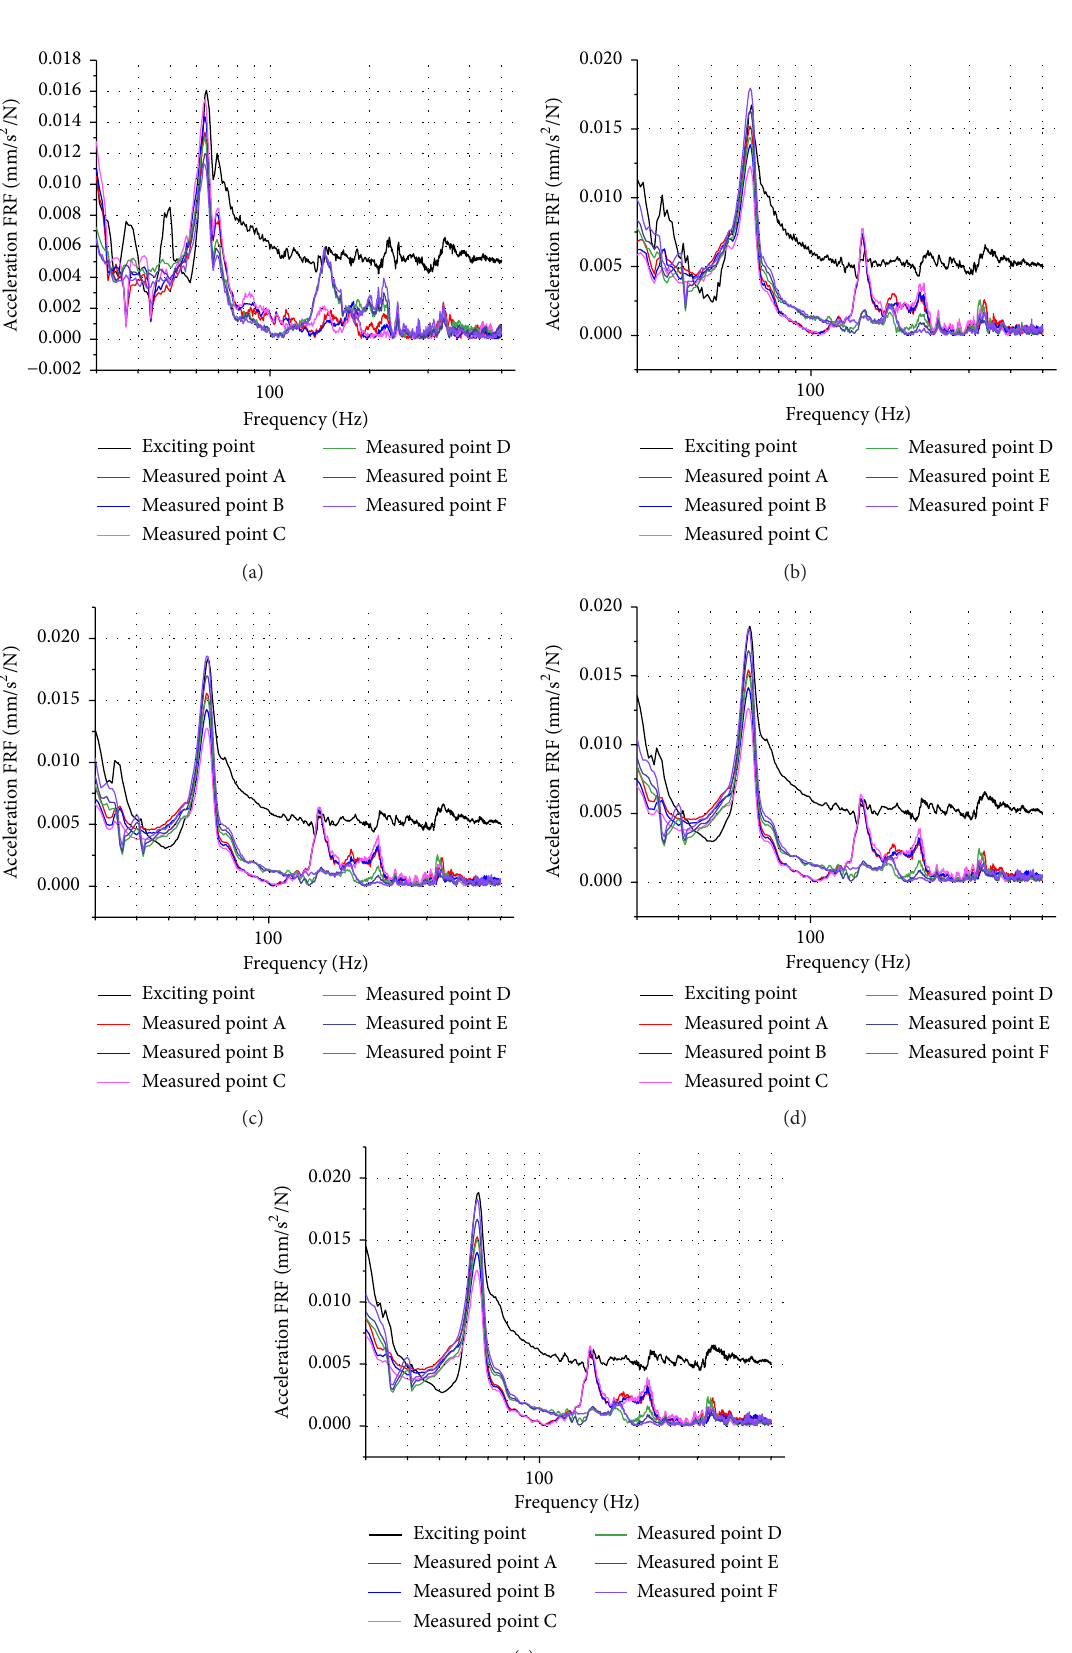
Figure 27: Acceleration FRF of the control base with different exciting forces: (a) 10N, (b) 20 N, (c) 30 N, (d) 40N, and (e) 50